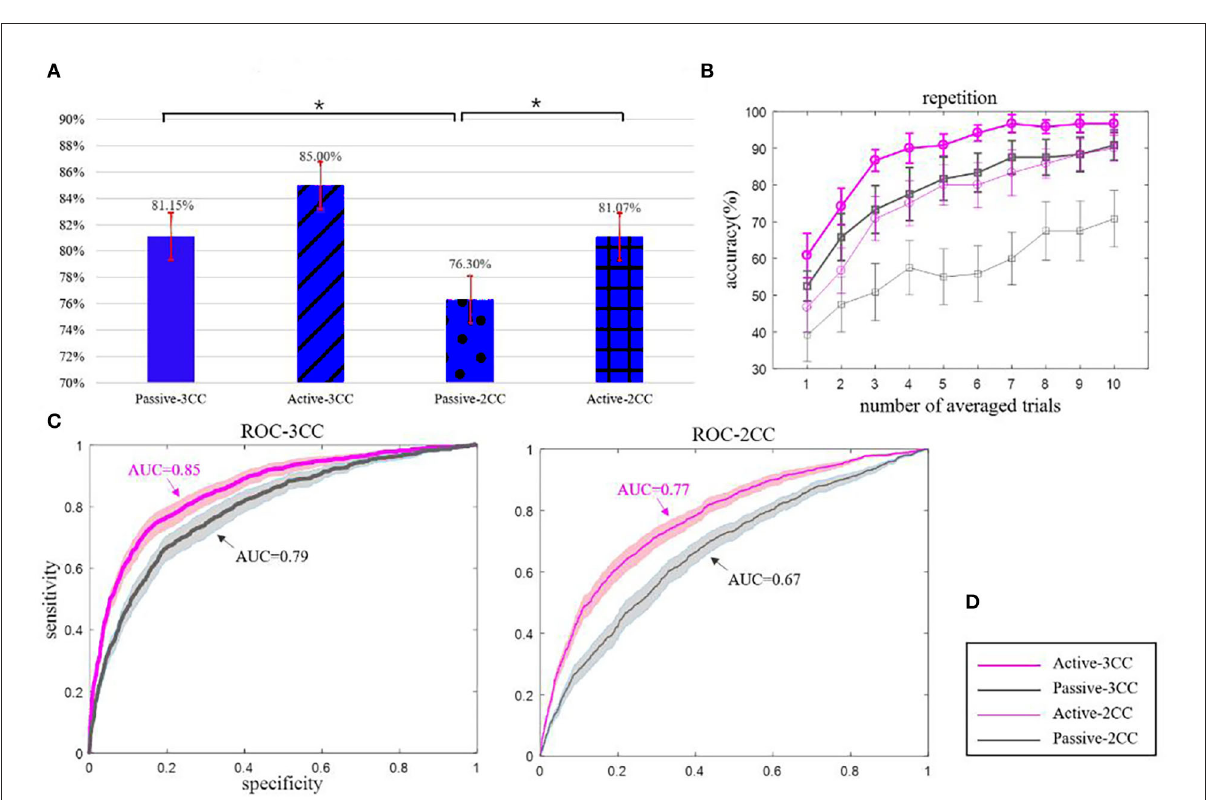
FIGURE6 (A) represents the binary classification accuracy of four conditions, (B) represents the repetition results with the fold from 1 to 10, (C) represents the ROC curves of 3CC and 2CC non-targets, and (D) represents the legend. The thick and thin lines represent 3CC non-targets and 2CC non-targets, and pink and gray colors represent active and passive states, respectively. The black solid asterisks denote the significant differences. They are all average values of 12 people, and error bars and colored areas are the means and standard errors (Mean